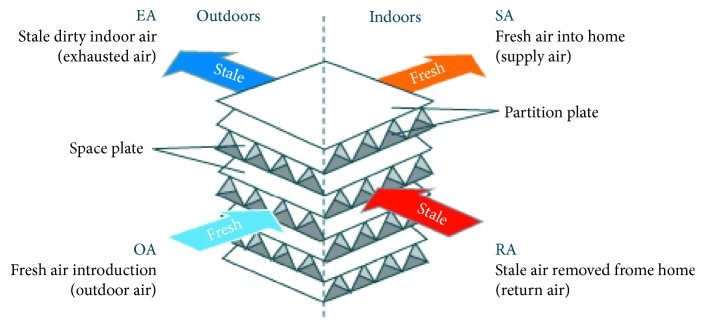
Polymer fixed plate [21].